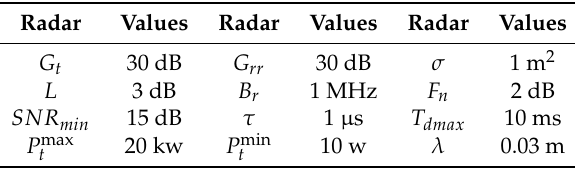
Table 1. Parameters of the airborne